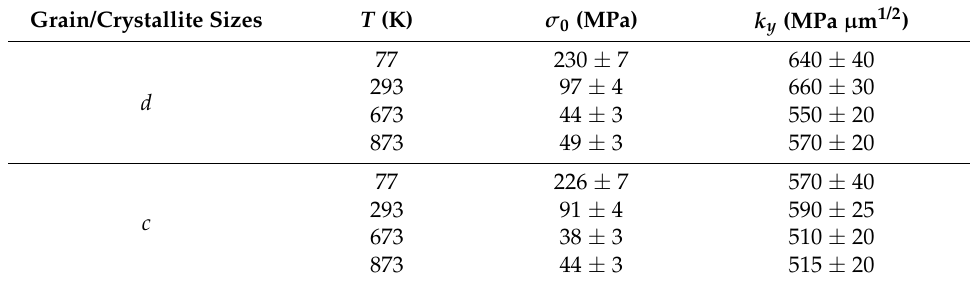
Table 2. Hall–Petch parameters ( σ 0 and k y ) determined by fitting Equation (1) to the grain size ( d , upper part) and crystallite size ( c , lower part) data sets obtained at different